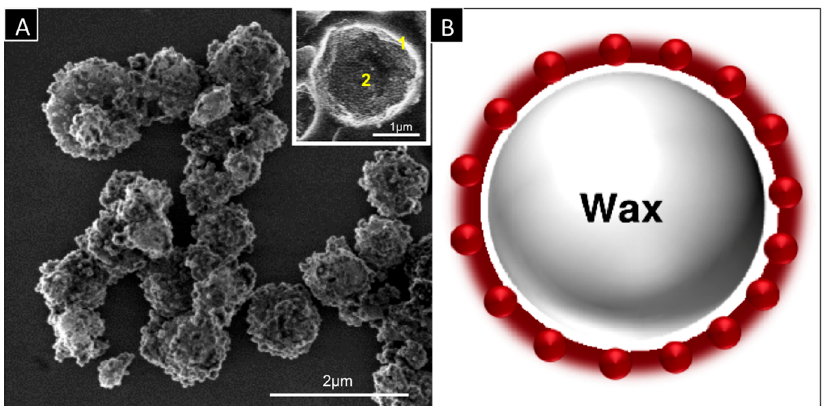
Figure 1. ( A ) SEM image of a smart capsule with a diameter of 1–3 μ m, showing (1) silica capsule wall with a thickness of 0.15–0.3 μ m and (2) docosane wax core with a melting range of 45–47 °C; ( B ) Schematic representation of cross-sectional area of a smart capsule.